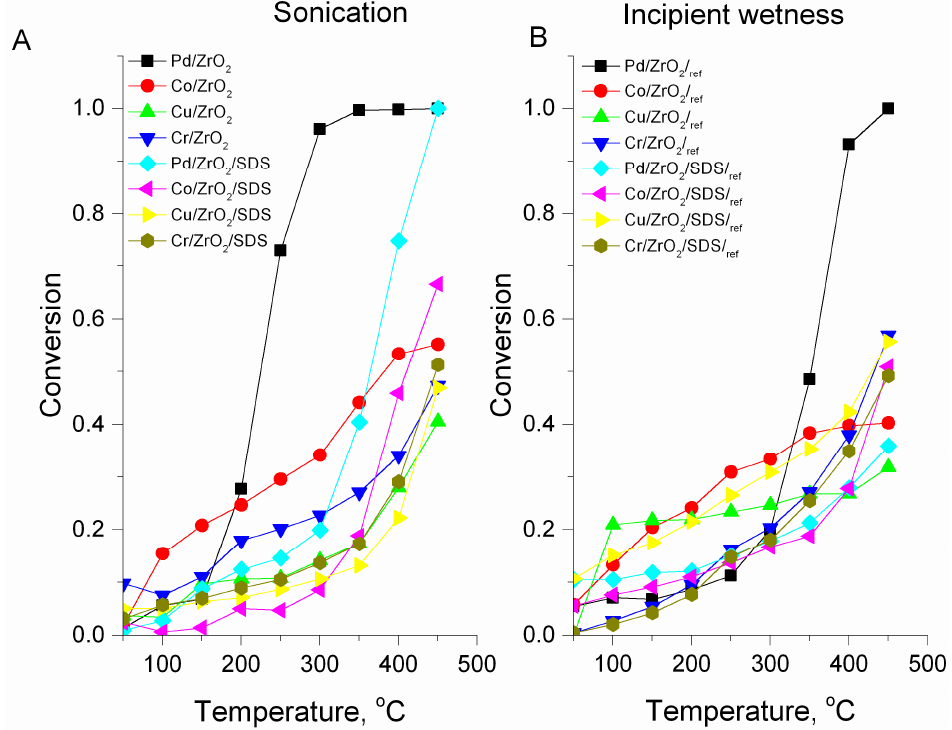
Figure 6. Methane catalytic combustion test results: ( A ) catalysts prepared via the sonochemical route; ( B ) reference catalysts prepared via the incipient wetness method.